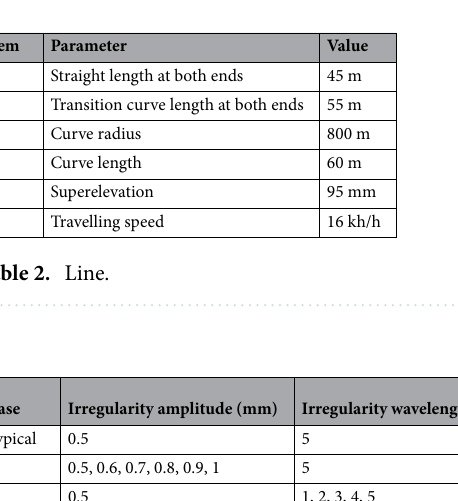
Figure 5. Mechanical-electric-hydraulic coupling